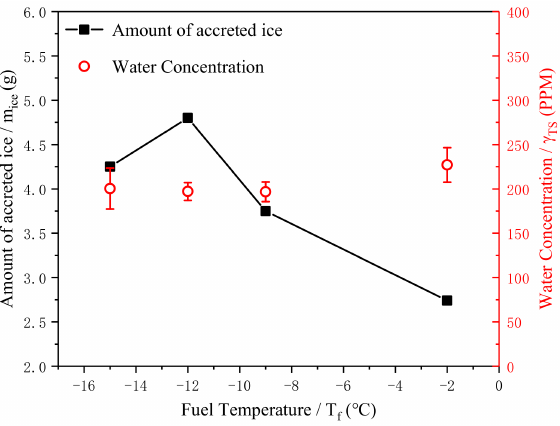
Figure 8. Mass of accreted ice in the upstream test section versus the fuel temperature.